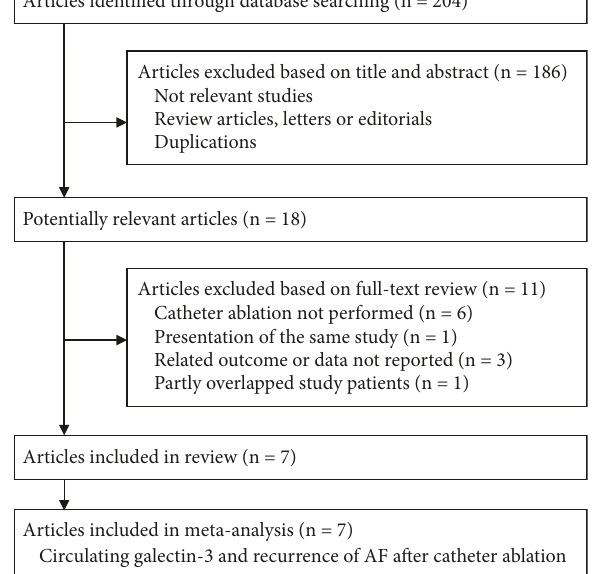
Figure 1: Flowchart of database